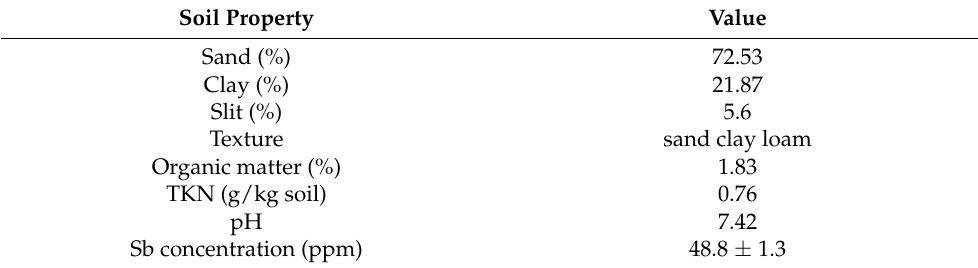
Table 3. Physical and chemical characteristics of the soil used in this